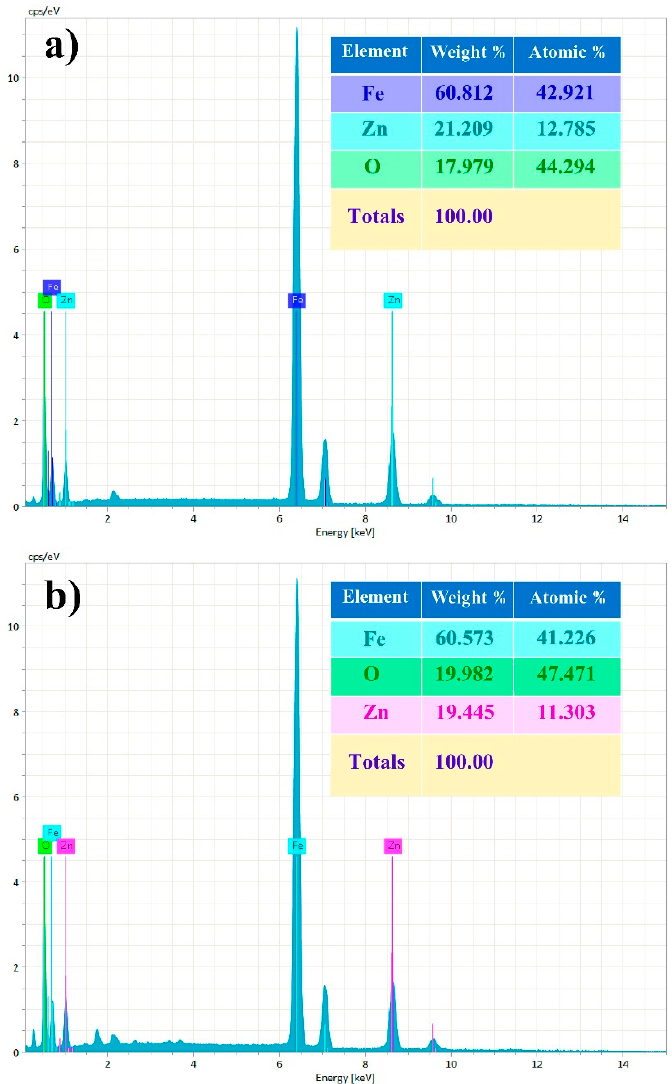
Figure 6. EDX spectrum of the Fe 2 O 3 :ZnO target ( a ) and the film ( b ). EDX spectroscopy yielded the e-mapped images of the Fe 2 O 3 :ZnO film confirming the uniform distribution of O, Al, Zn, and Fe elements, with the distinctive characteristic lines of X-ray intensity (Figure 7).